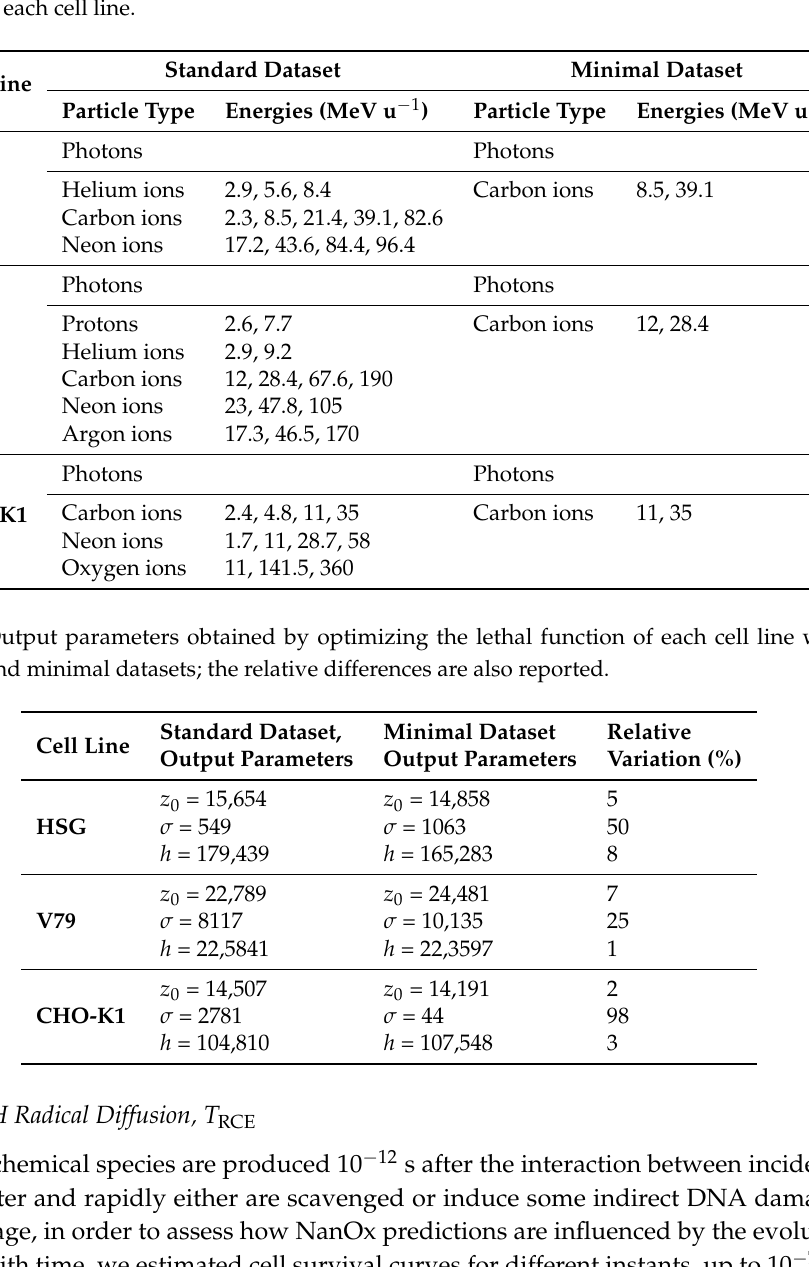
Table 3. Standard and minimal experimental datasets used as input to optimize the effective lethal function of each cell line.